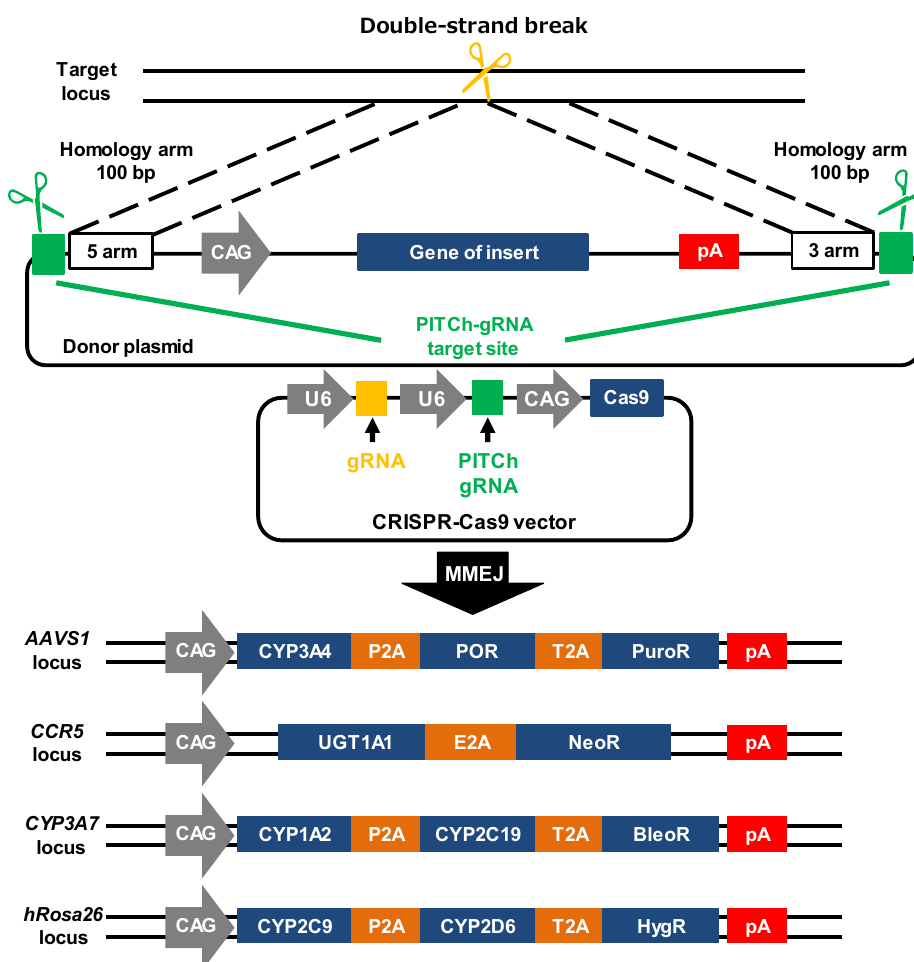
Figure 1. Generation of CYPs–UGT1A1 KI-HepG2 cells. This schematic overview shows the tar- geting strategy for AAVS1 , CCR5 , CYP3A7 , or hROSA26 loci. Donor and CRISPR-Cas9 plasmids: CAG, cytomegalovirus (CMV) early enhancer/chicken β actin promoter; U6, U6 promoter; PITCh, Precise Integration into Target Chromosome; MMEJ, microhomology-mediated end joining; AAVS1, adeno-associated virus integration site 1; CCR5, C–C chemokine receptor type 5; CYP3A7, cytochrome P450 family 3 subfamily A member 7; hROSA26, human ROSA26; P2A, self-cleaving P2A peptide sequence; T2A, self-cleaving T2A peptide sequence; E2A, self-cleaving E2A peptide sequence; CYP1A2, cytochrome P450 family 1 subfamily A member 2; CYP2C9, cytochrome P450 family 2 subfamily C member 9; CYP2C19; cytochrome P450 family 2 subfamily C member 19;